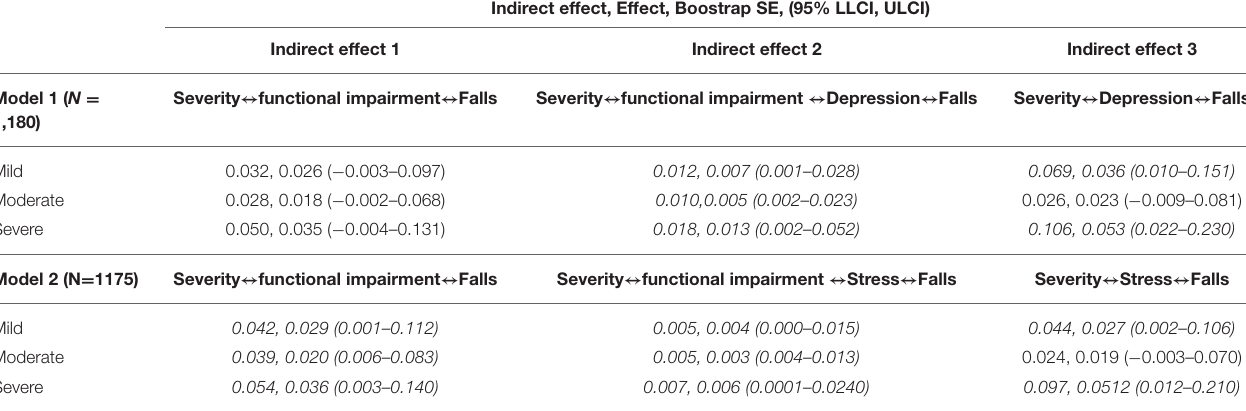
TABLE 4 | Specific indirect effects of mediators for the knee pain severity and